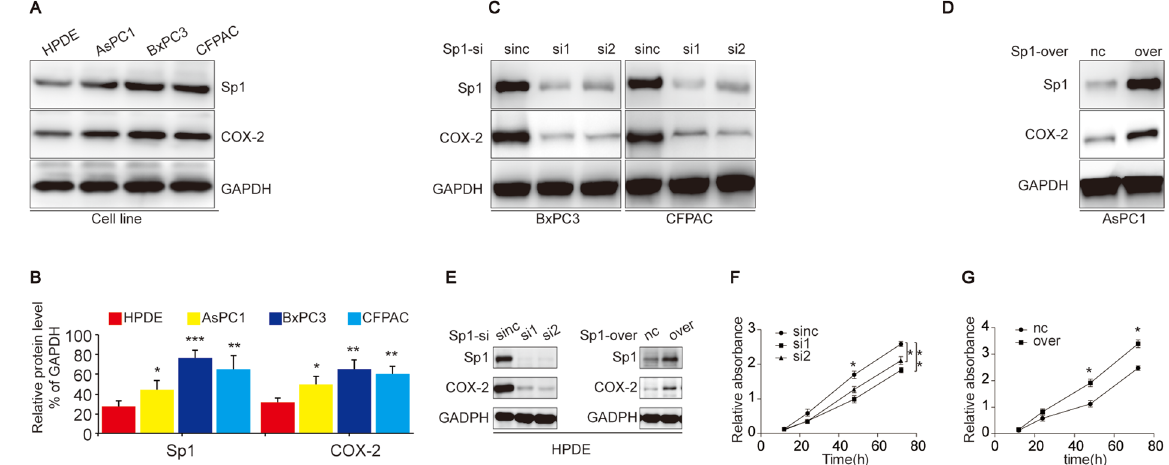
Figure 2. Correlated COX-2 and Sp1 expression in PDAC cell lines. ( A ) Detection of Sp1 and COX-2 expression in PDAC cell lines (BxPC3, CFPAC and AsPC1) and human pancreatic duct epithelial (HPDE) cells. ( B ) Relative densities of Sp1 and COX-2 expression are presented as Mean ± S.E (n = 3) of the fold change relative to GAPDH. * P < 0.05 and ** P < 0.01. ( C ) Western blot showing COX-2 expression in BxPC3 and CFPAC cells upon Sp1 knockdown. ( D ) Western blot showing COX-2 expression in AsPC1 cells upon Sp1 overexpression. ( E ) Western blot showing Sp1 and COX-2 expression in HPDE cells upon Sp1 knockdown and overexpression. ( F,G ) CCK8 assay toward HPDE cells upon Sp1 knockout and overexpression.